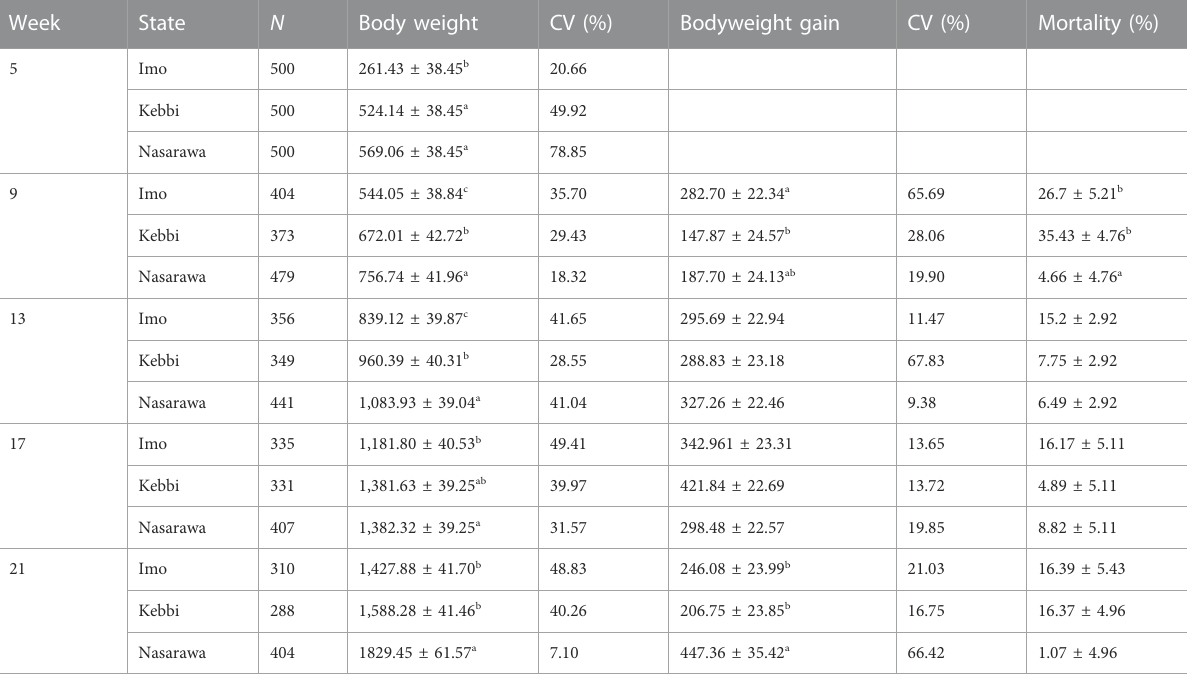
TABLE 2 Effect of agro-ecological zones on body weight, weight gain, and mortality (LSM ± SE).